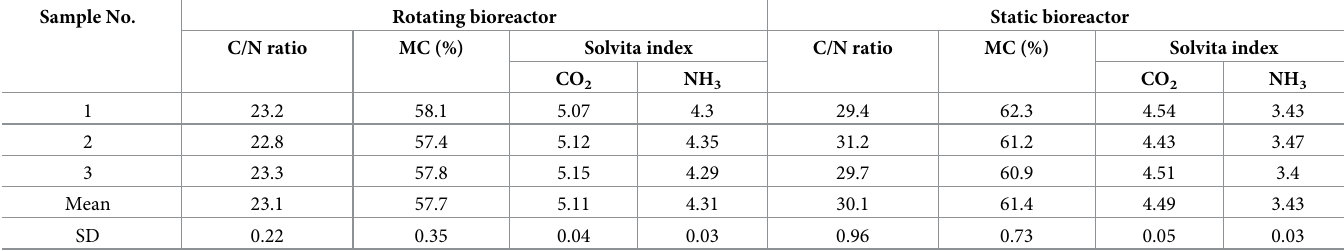
Table 2. Results of the solvita test for six samples of compost taken from the static and rotating bioreactors. Sample No.